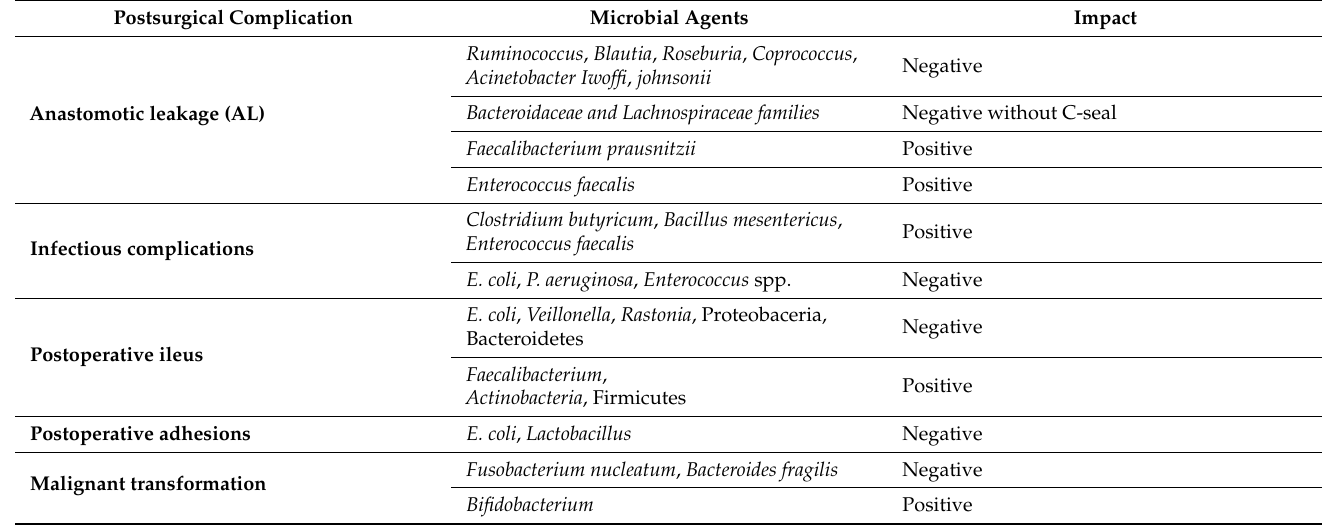
Table 1. Summary of prevalent bacteria found in association with main postsurgical complica- tions. Impact Negative—the microbial agents are associated with increased risk for postsurgical complication. Impact Positive—the microbial agents are associated with decreased risk of postsurgi- cal